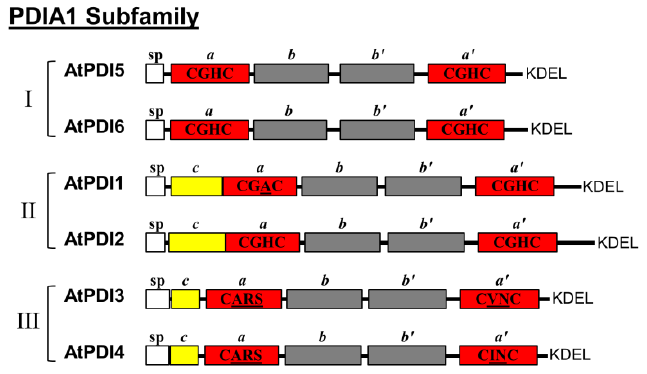
Figure 1. Domain arrangements of PDIA1, PDIA6, and PDI-D homologs from Arabidopsis . Red boxes correspond to thioredoxin-like catalytic domains ( a , a′ , a o ), and grey boxes are non-catalytic thioredoxin-fold domains ( b, b′ ). The signal peptides (sp) are represented as white boxes, and acidic regions ( c ) as yellow boxes. The D domain of PDI-D proteins is depicted as a blue box. The active site sequences of each catalytic domain are shown, with residues deviating from the typical CGHC motif underlined. The last four amino acids are shown at the end of each depicted